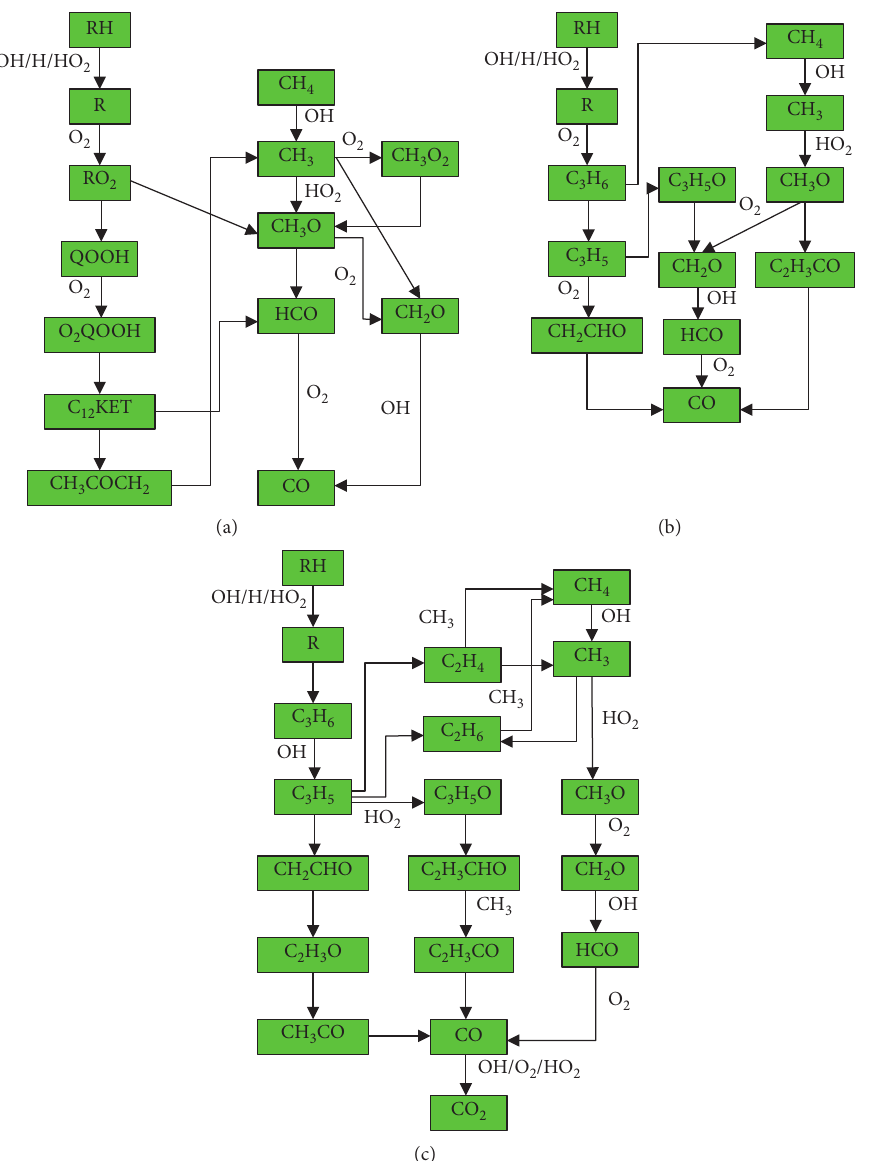
Figure 12: Reaction pathway of different methane conversion rates: (a) 1% methane conversion rate, (b) 10% methane conversion rate, and (c) 50% methane conversion